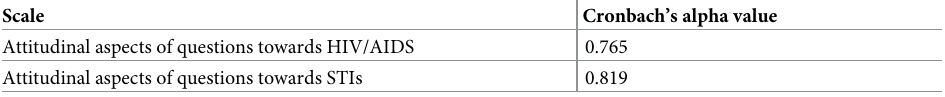
Table 1. Reliability score of attitudinal aspects of questions towards HIV/AIDS and STIs